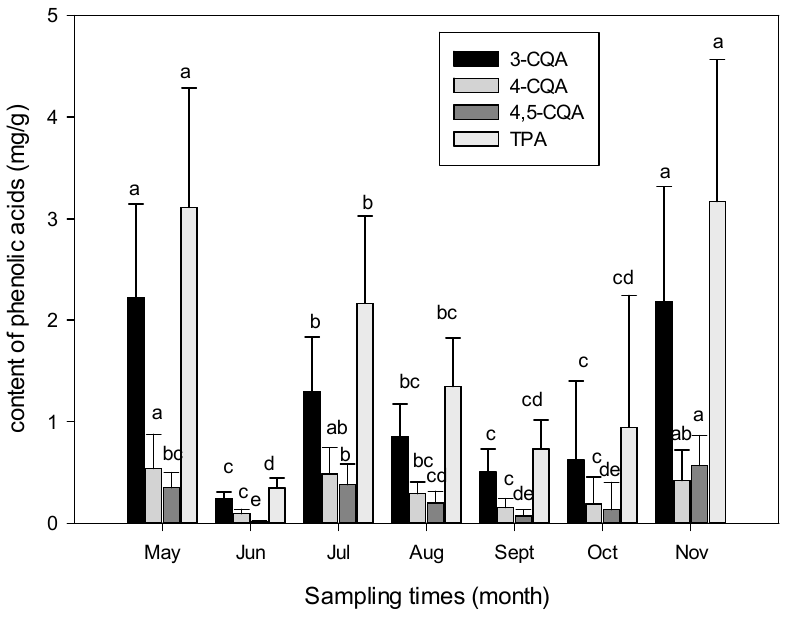
Figure 2. Seasonal variation of phenolic acids in leaves of C. paliurus (mean ± SD). 3-CQA, 4-CQA, 4,5-CQA, and TPA represent 3- O -caffeoylquinic acid, 4- O -caffeoylquinic acid, 4,5-di- O -caffeoylquinic acid, and total phenolic aids, respectively. Different letters in this figure indicate significant differences between the sampling times for the same category according to Duncan’s test ( p < 0.05). Each value presented is the mean of the 10 sampled families.